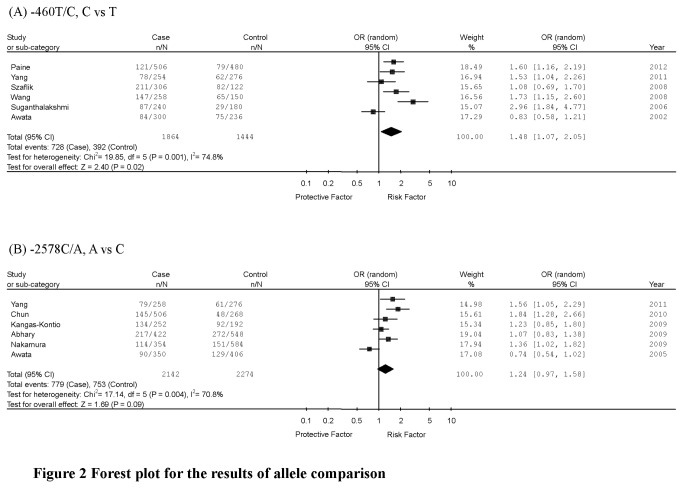
Forest plot for the results of allele comparison.